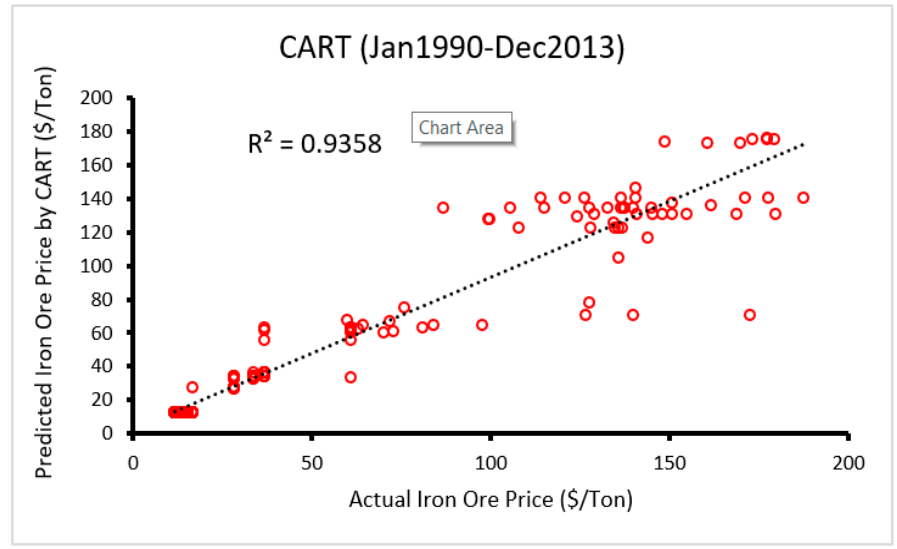
Figure 5. Scatter plot of the predicted vs. actual iron ore price through the use of classification and regression tree (CART) model.